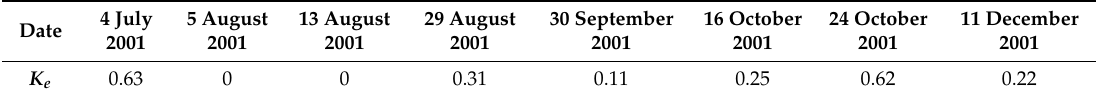
Figure 2. Daily evapotranspiration map for the days of satellite overpasses based on the Mapping EvapoTranspiration at high Resolution with Internalized Calibration (METRIC) model. Table 2. Evaporation coefficient ( K e ) for the hot pixel used in the Mapping EvapoTranspiration at high Resolution with Internalized Calibration (METRIC) model on the date of satellite overpasses.